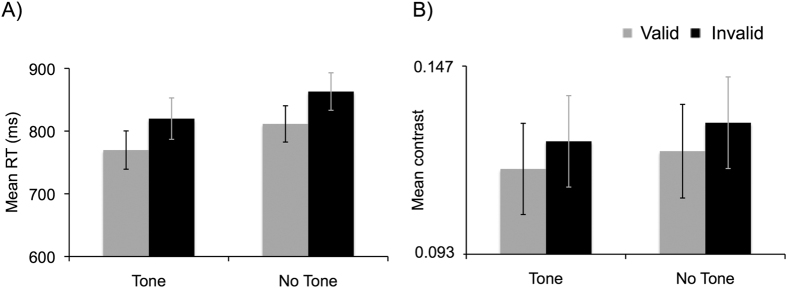
(A) Mean RT in the objective task for consciously reported Gabors as a function of Alerting and Validity. (B) Mean Michelson contrast values used to achieve ~50% “seen” and “unseen” targets (in the subjective task) as a function of Alerting State and Validity. Error bars represent standard errors.